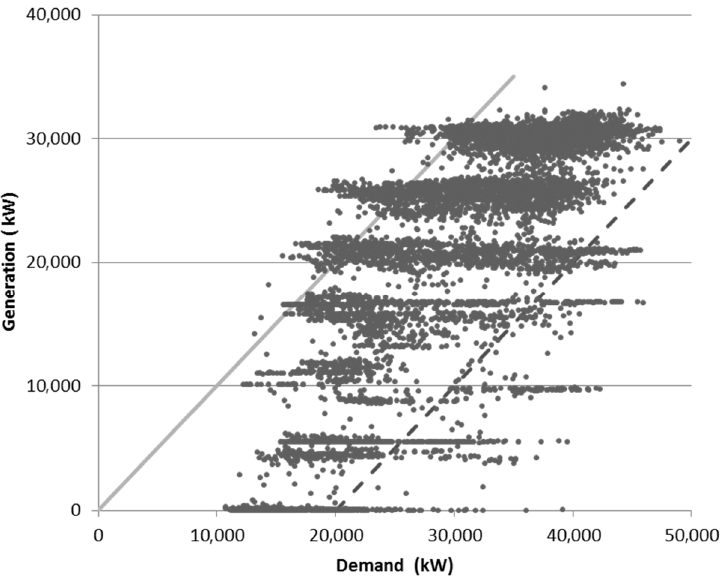
Figure 7. Hourly demand and generation levels in transformation K6 in 2014.